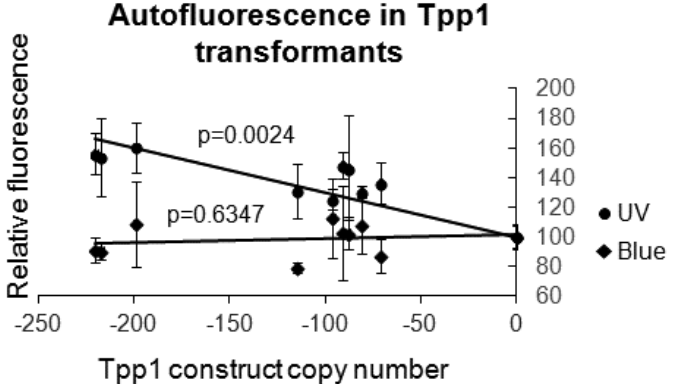
Figure 2. Dictyostelium Tpp1 mutants display increased autofluorescence in UV but not blue light. Fluorescence values were measured for wild type AX2 and Tpp1 mutant cells grown in Lo-Flo HL-5 using the UV (excitation λ = 365 nm, emission λ = 410–460 nm) or Blue (excitation λ = 460 nm, emission λ = 515–570 nm) Modules in a Turner modular flourometer. The values were normalised to AX2 and plotted against the Tpp1 antisense inhibition construct copy number. The amount of fluorescence measured with the UV module increased with increasing copy number and was unchanged when measured with the Blue module, as expected for lipofuscin-associated autofluorescence. Data are the mean from three independent experiments and error bars represent standard deviation. The regressions were significant at indicated p values (t test). The lines were fitted by the linear least squares method.